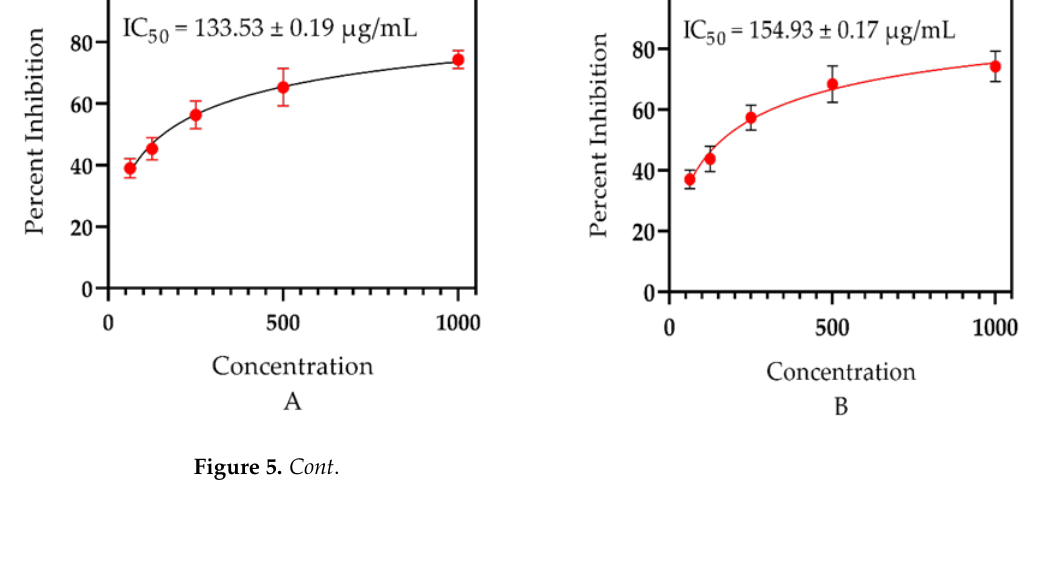
Figure 5. ( A ) Antioxidant significance of ELEO using DPPH assay, ( B ) antioxidant capability of E. larica essential oil via ABTS assay, ( C ) antioxidant effect of the standard ascorbic acid via DPPH, and ( D ) antioxidant activity of the standard via ABTS assay. Our current findings consented with the data stated by Elshamy et al. [94] and Essa et al. [47] for the essential oils of E. heterophylla and E. mauritanica L., as the plant species under study belongs to the same genus, having the majority of common bioactive constituents which can neutralize the free radicals. However, our data did not match with the study doc- umented by Jie et al. [46], and the plant studied, Euphorbia fischeriana , belongs to the same genus collected from China. The chemical ingredients vary among the plants of the same genus due to their habitat, quality, and availability of water. In addition to that, plant species from a different genus, Ochradenus , presented similar antioxidant potential due to the same method of essential oil extraction, habitat, and a similar approach used to examine the free radical scavenging effect, as revealed in the literature of Ullah et al. [37]. 4.6. Anti-Inflammatory Significance The essential oil of E. larica was examined to highlight the anti-inflammatory capabili- ties induced via carrageenan in Swiss albino mice. The essential oil presented significant potential in the reduction in paw edema from low to high doses at 55.40%, 58.78%, and 65.54%, respectively, as equated to the standard with 73.64% inhibition (Table 3). At the same time, the normal saline was observed to be inactive (Table 4). Our current findings